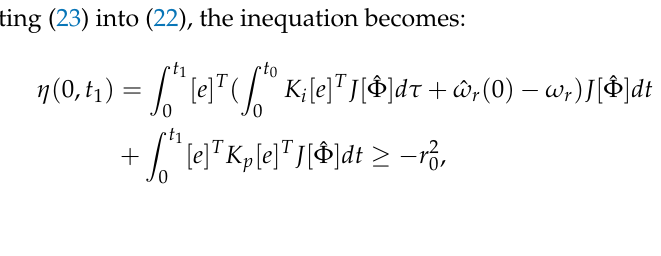
Figure 11. Poles loci for forward path transfer